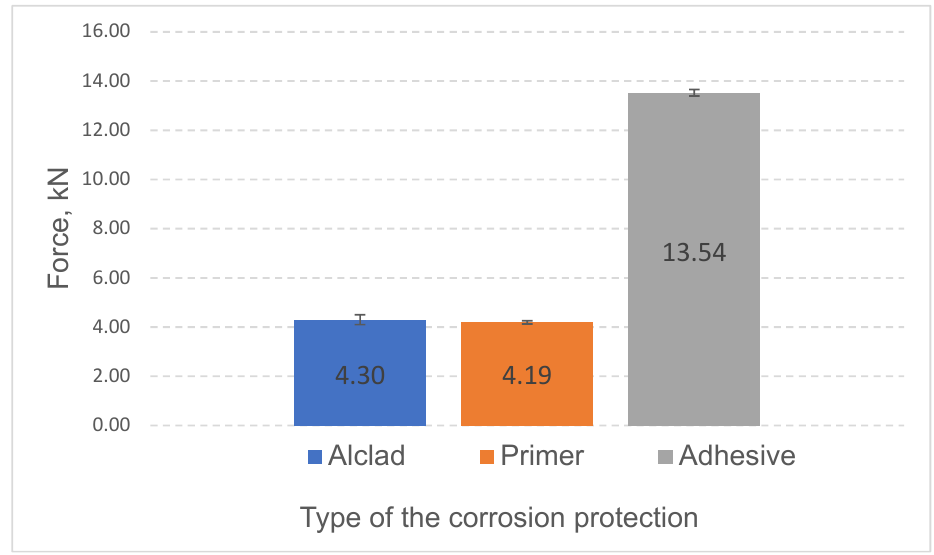
Figure 10. Microhardness of RFSSW .